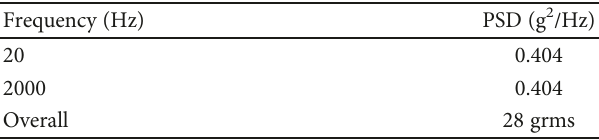
Figure 7: Daisy-chain circuit for CCGA624 package. Table 4: Speci fi cation of random vibration.